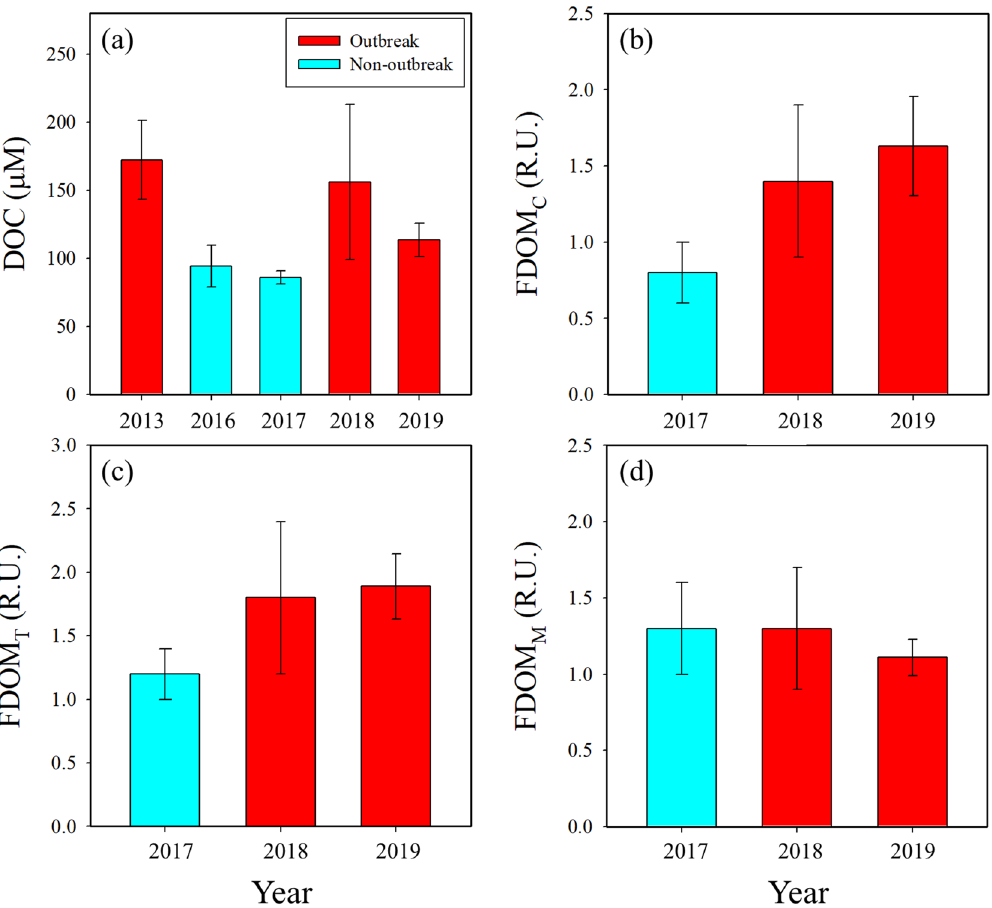
Figure 6. Average concentrations of ( a ) DOC, ( b ) FDOM C , ( c ) FDOM T , and ( d ) FDOM M in coastal waters off Tongyeong, Korea, during the summers from 2013 to 2019. The DOC concentrations in 2013 and 2016 in the red tide regions of Tongyeong were obtained from Kwon et al. 14